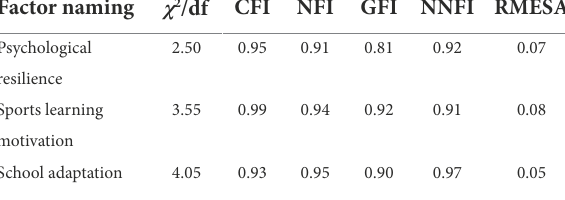
TABLE 1 Results of confirmatory factor